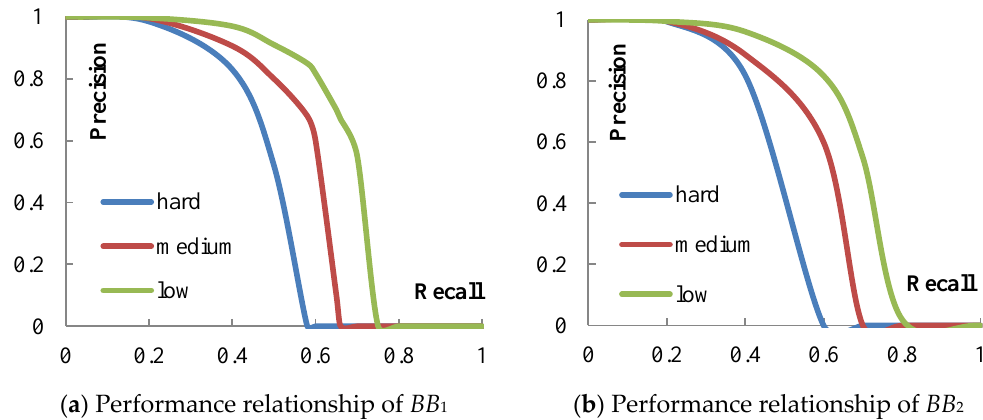
Figure 11. Detection performance of the target. ( A ) is the performance relationship of model BB 1 . ( B ) is the performance relationship of model BB 2 .